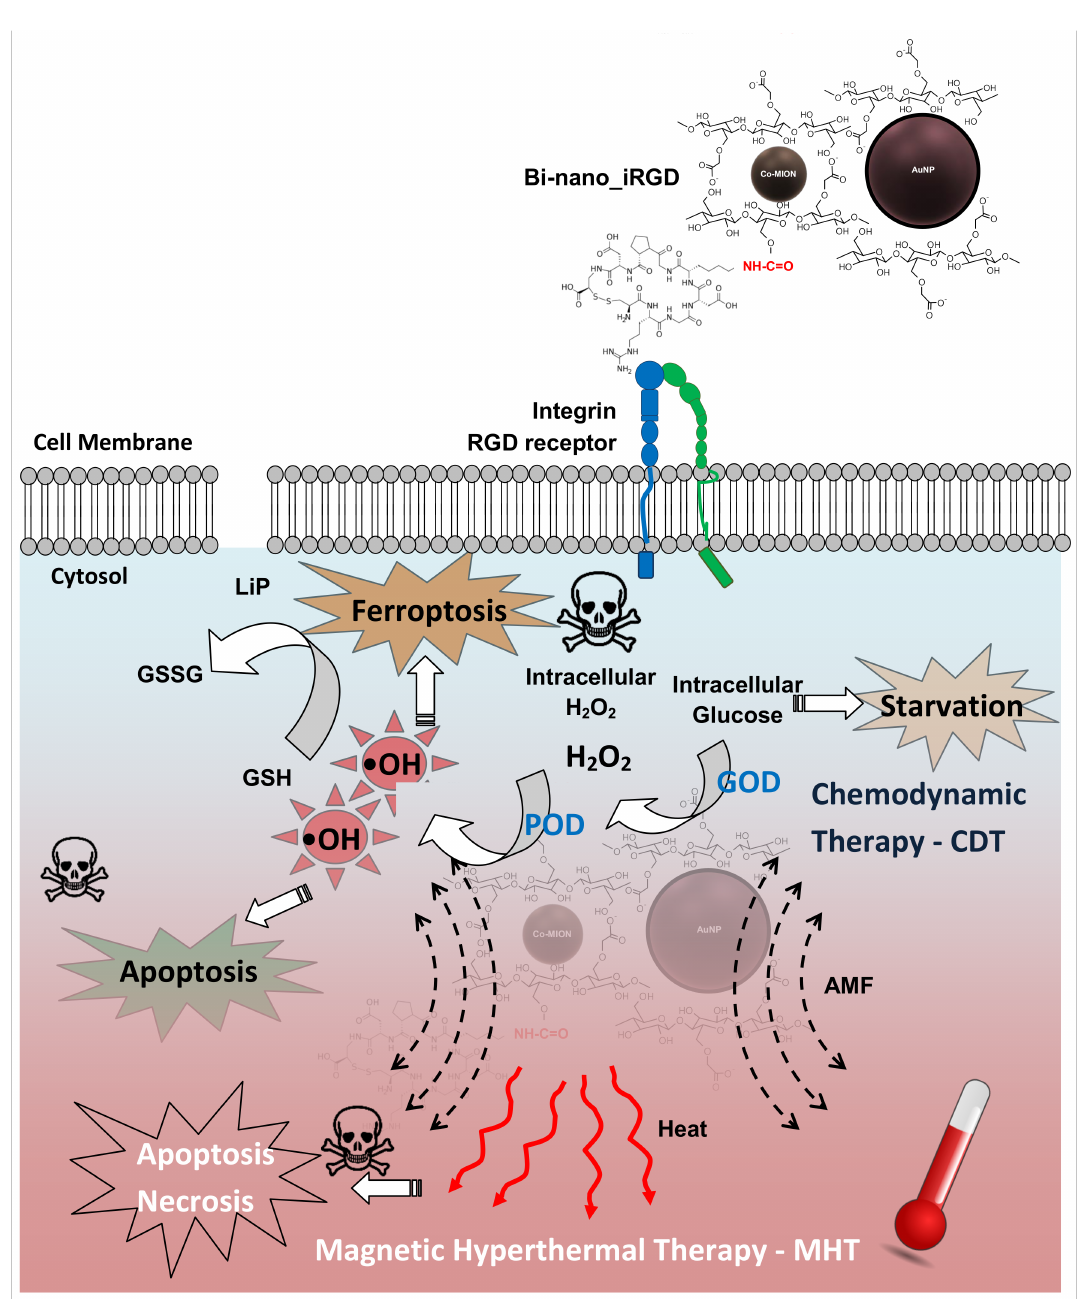
Figure 11. Schematic representation of the developed peptide-functionalized biopolymer magneto- responsive dual-nanozyme hybrid nanoassemblies targeted toward biocatalytic hyperthermal chemo- dynamic therapy of brain cancer